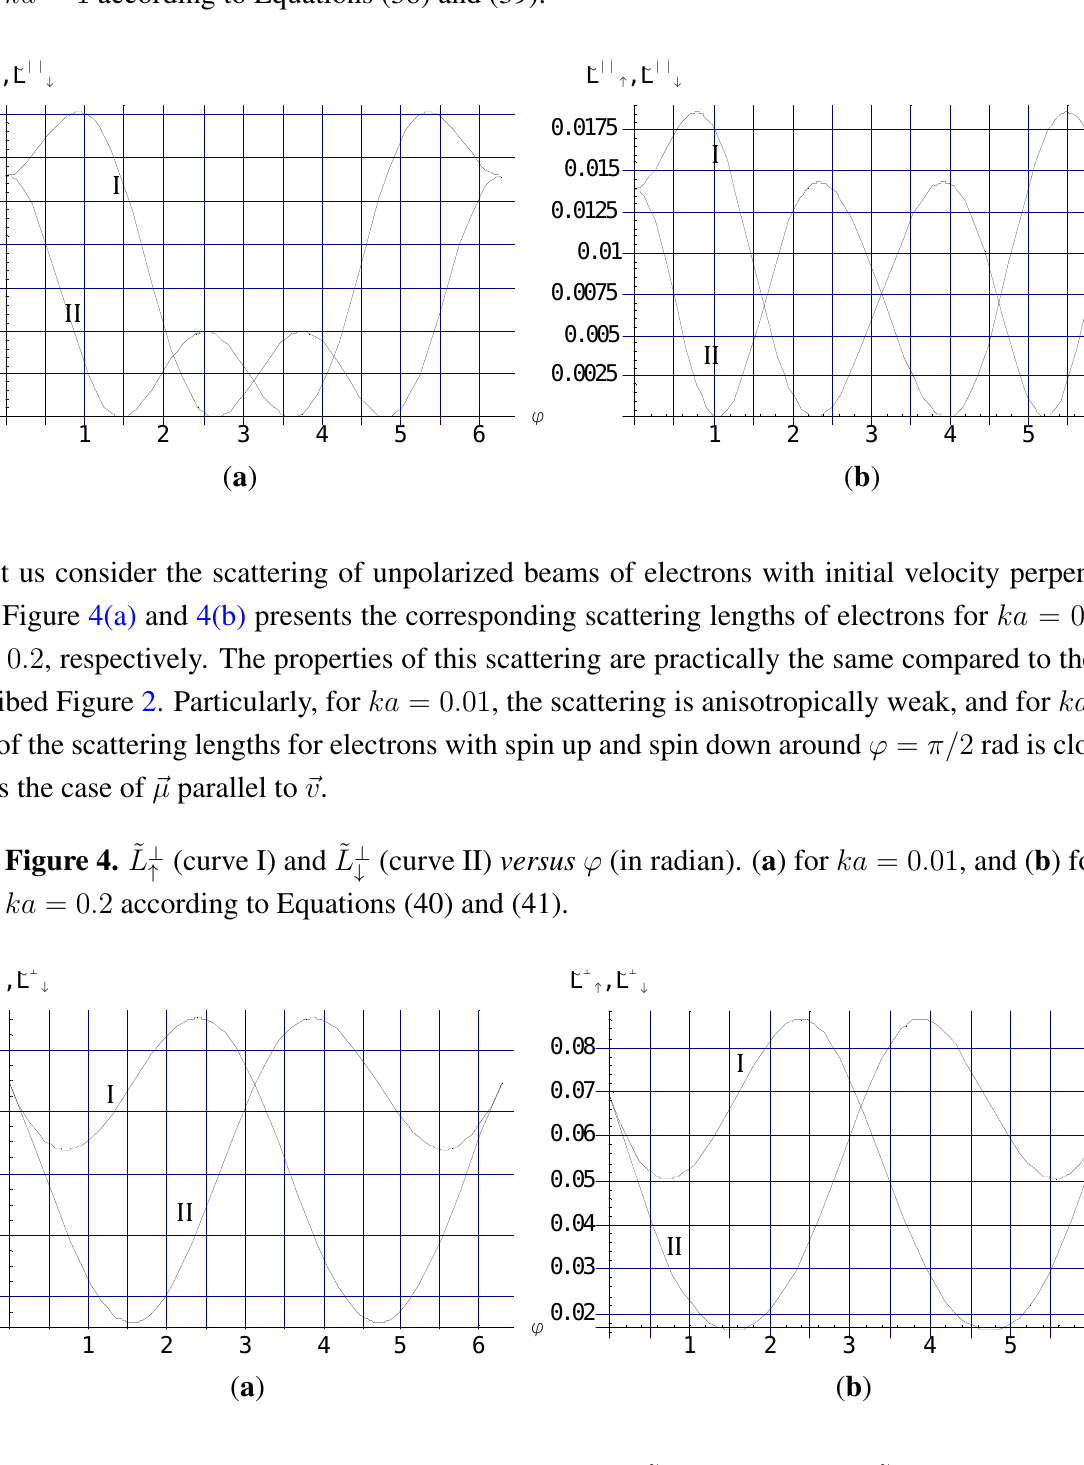
Figure 3. ˜ L (cid:107) (curve I) and ˜ L (cid:107) (curve II) versus ϕ (in radian). ( a ) for ka = 0 . 5 , and ( b ) for ↑ ↓ ka = 1 according to Equations (38) and (39).